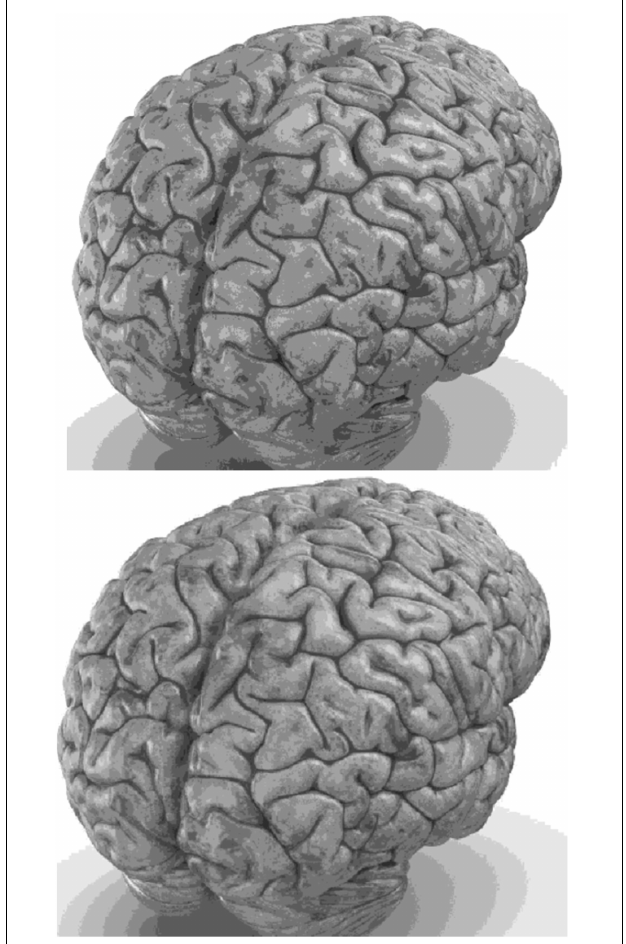
FIGURE 6 | The results of a typical type-2 fuzzy neural network for two-dimensional interpolation. FIGURE 7 | 3D image of the rear view